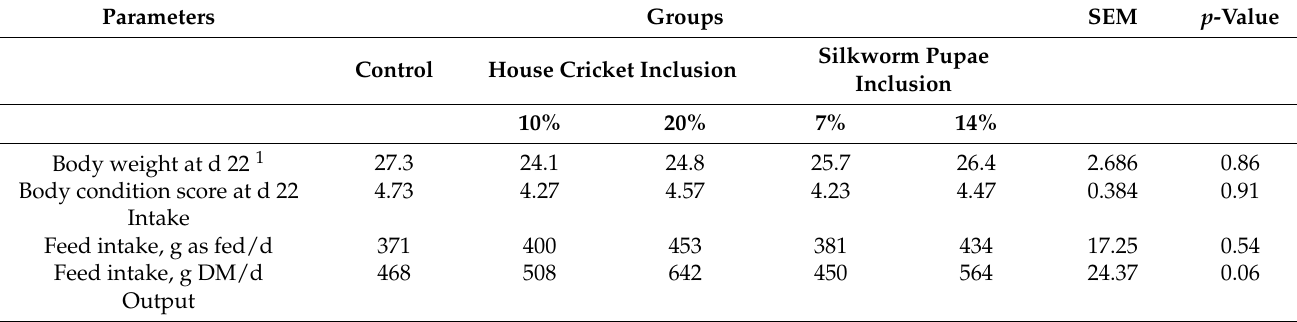
Table 3. Body weight, body condition score, feed intake, faecal output, faecal score, faecal moisture, and apparent total tract digestibility (between day 23 and 28) in mixed-breed dogs (2–4 years old; n = 10 per group) with or without inclusion